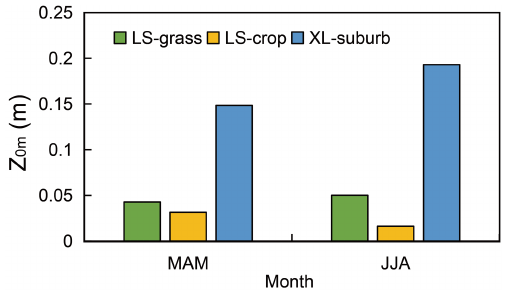
Figure 14. Seasonal averages of surface roughness length at the four sites in Nanjing for the spring and summer of